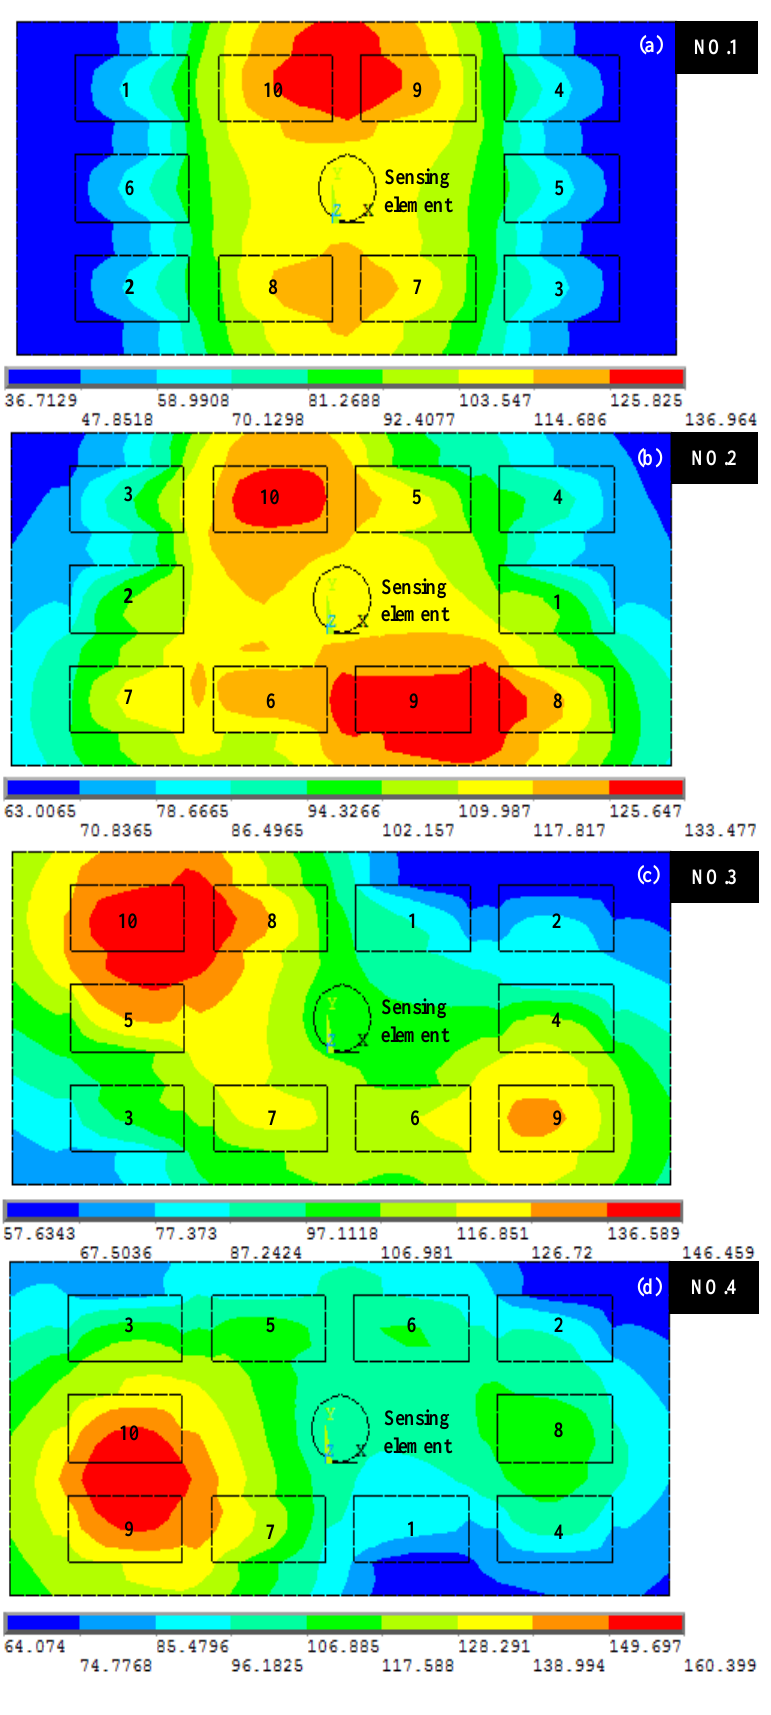
Figure 11. A set of four temperature field distribution diagrams for the random PCB layouts before the layout